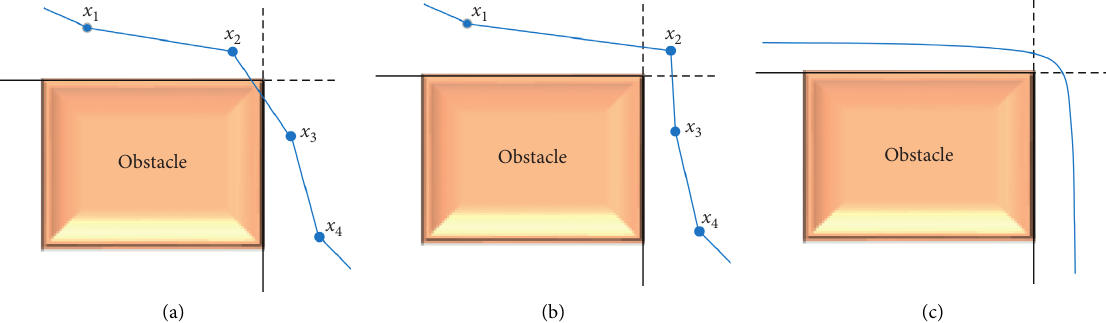
Figure 1: (a) Conventional model-predictive control-based path planning requires that states are outside of polygonal obstacles resulting in the path cutting through the obstacle. (b) The MILP approach of using a straight-line trajectory between waypoints [22]. (c) The smooth and continuous path for MDT demonstration of obstacle